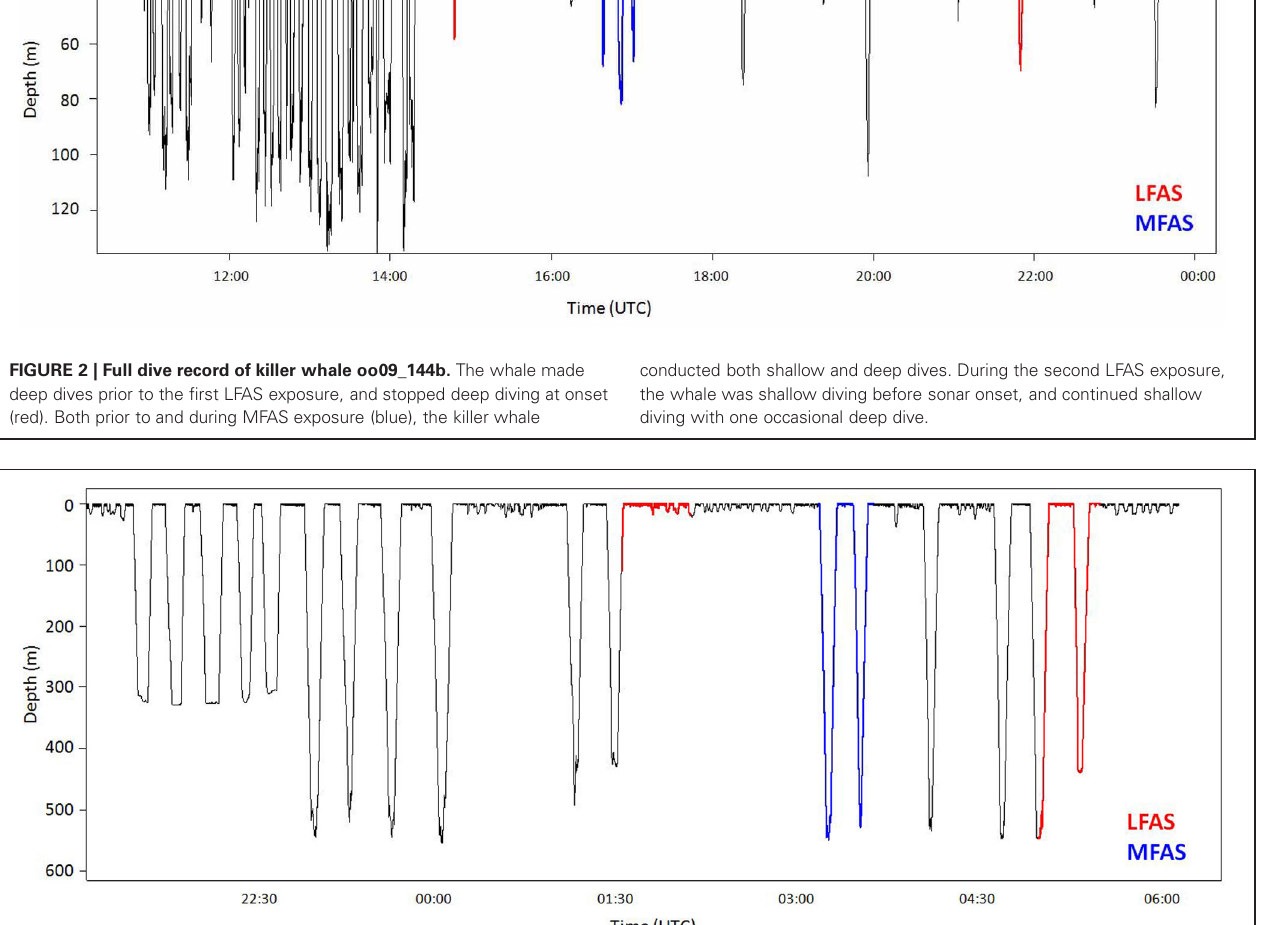
FIGURE 3 | Full dive record of pilot whale gm09_156b. This record show typical pilot whale diving behavior, with periods of shallow diving, followed by bouts of deep dives. Before onset of the first LFAS exposure, the whale conducted two deep dives, but turned to shallow diving at LFAS exposure